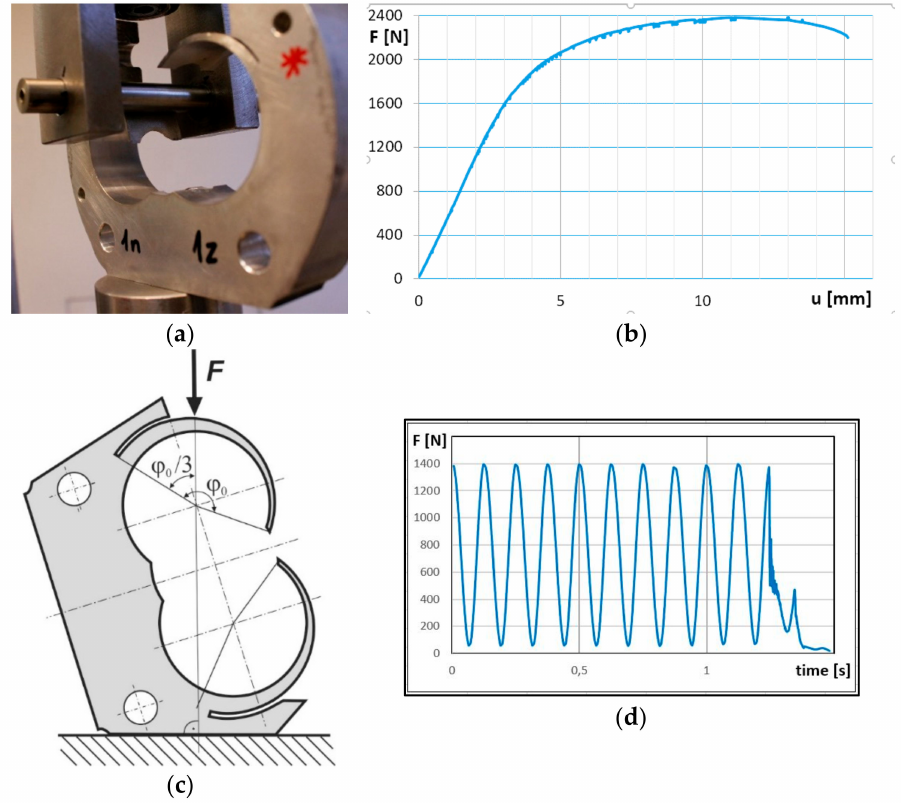
Figure 9. Experimental tests of the lip compensating circumferential backlash in a pump: ( a ) pump body during the static loading test, ( b ) static loading diagram for specimen 1, ( c ) fatigue test diagram; and ( d ) fatigue failure diagram at F z min/max = 50/1400 N, f = 10 Hz, N = 53,305 cycles for Specimen